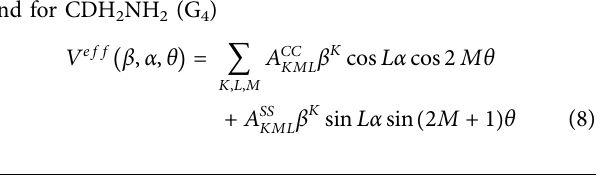
TABLE 5 | Symmetry eigenvectors. a